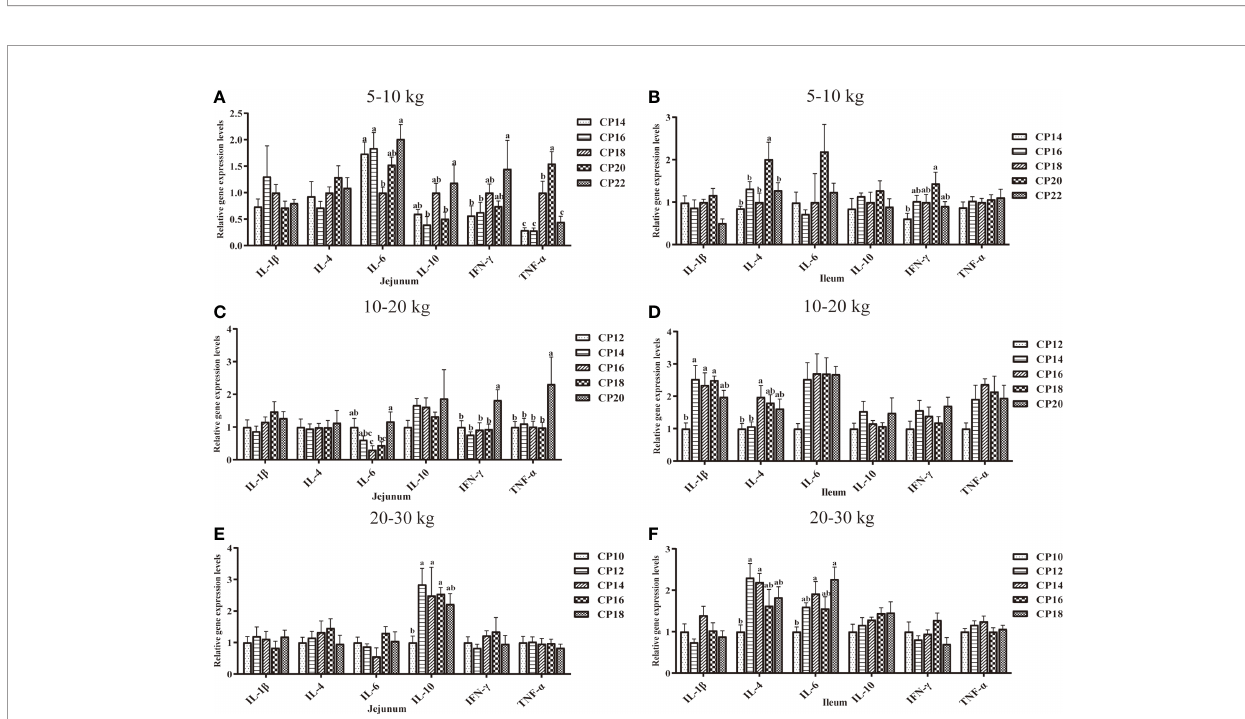
FIGURE 6 | Effects of dietary crude protein (CP) levels on the immunity-related gene expression in the small intestinal mucosa of Huanjiang mini-pigs during 5 − 10 kg ( A , jejunum; B , ileum), 10 − 20 kg ( C , jejunum; D , ileum), and 20 − 30 kg ( E , jejunum; F , ileum) growth stages. Data are presented as means ± SE ( n = 6 − 8 per group). Different superscript letters indicate signi fi cant differences among the fi ve groups ( P < 0.05). IL, interleukin; IFN, interferon; TNF- a , tumor necrosis factor-alpha.